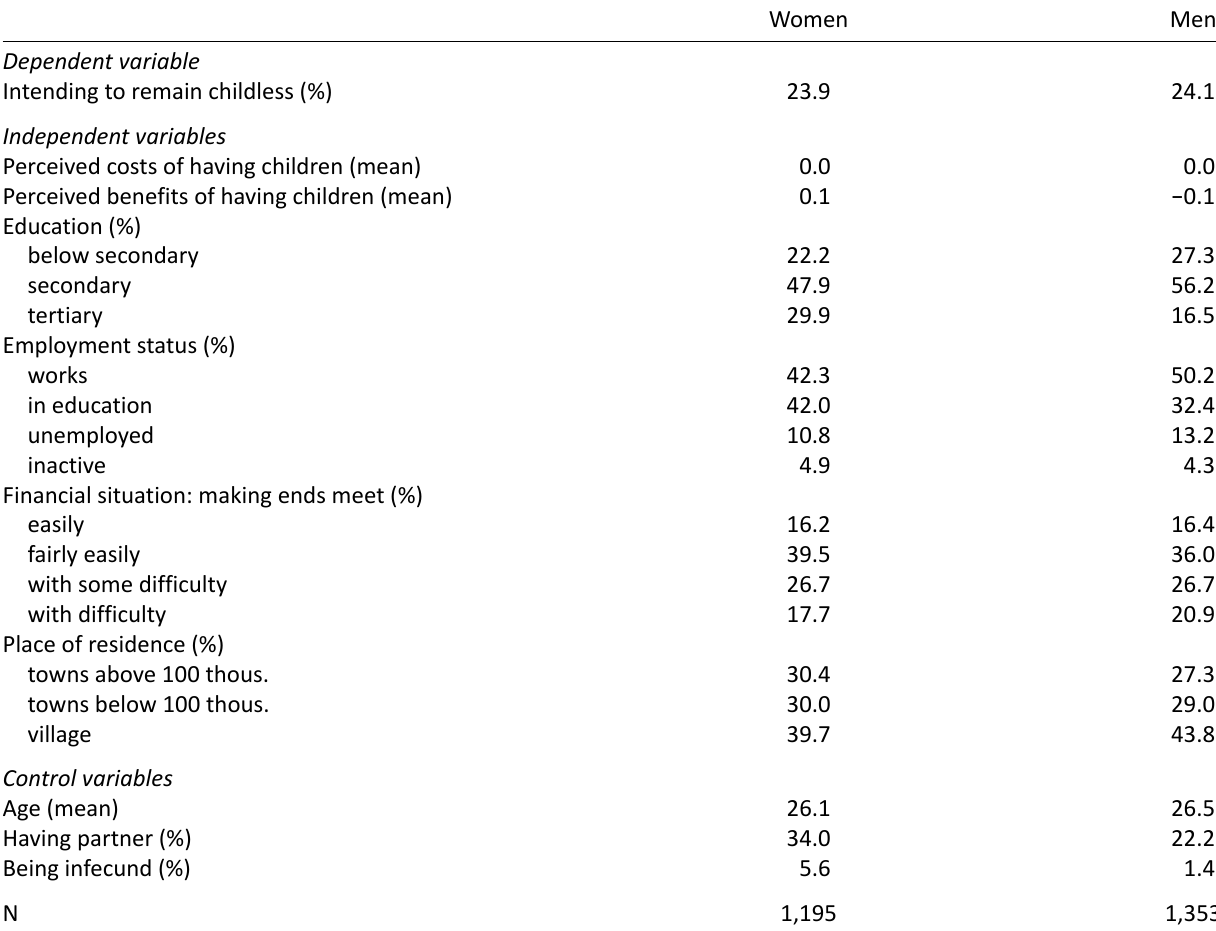
Table 1. Sample characteristics, unweighted